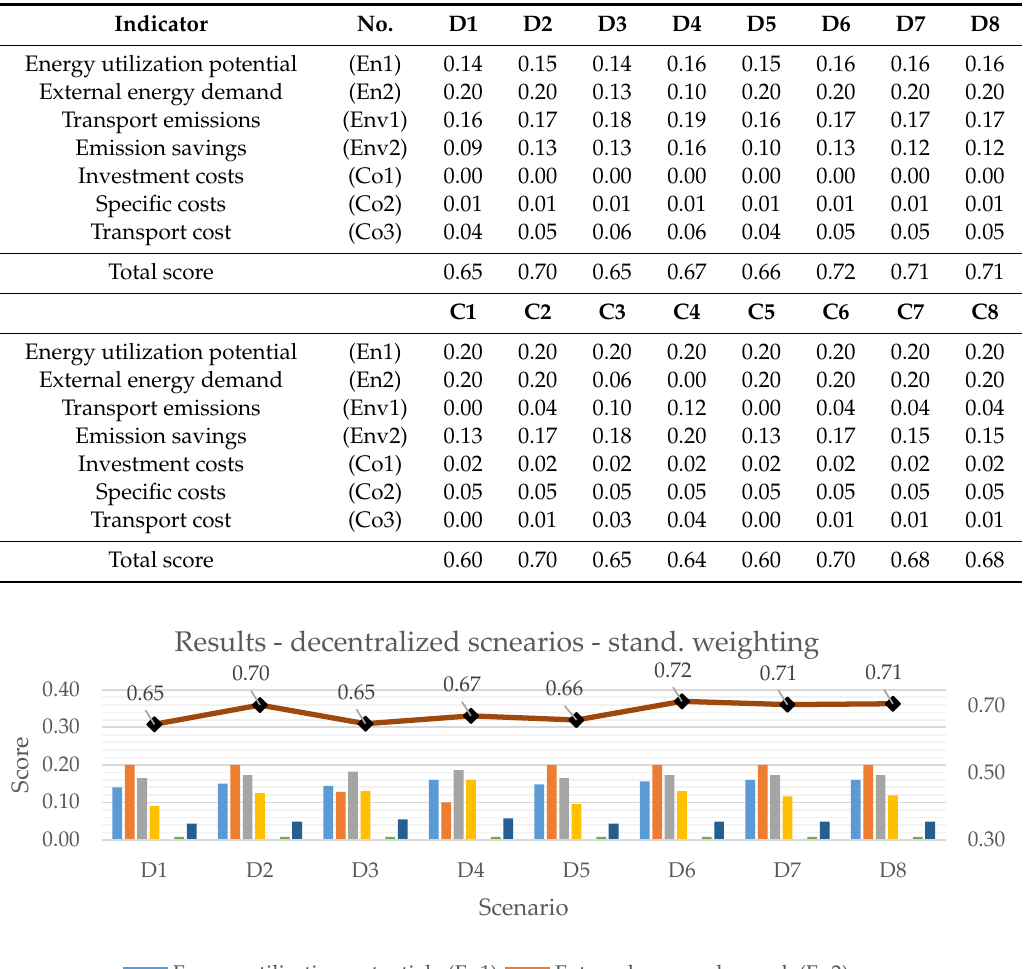
Table 10. Overall results of the MCA with the standard weighting.